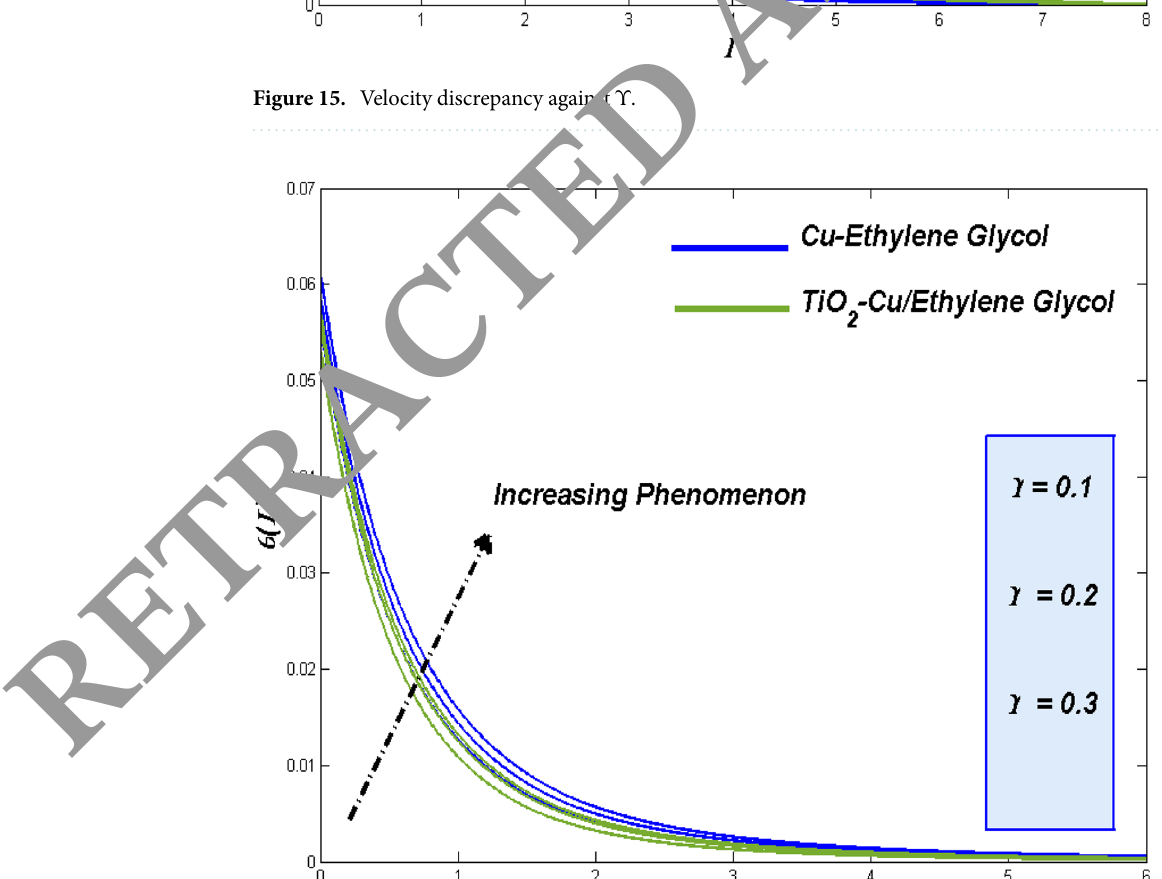
Figure 15. Velocity discrepancy against ϒ .